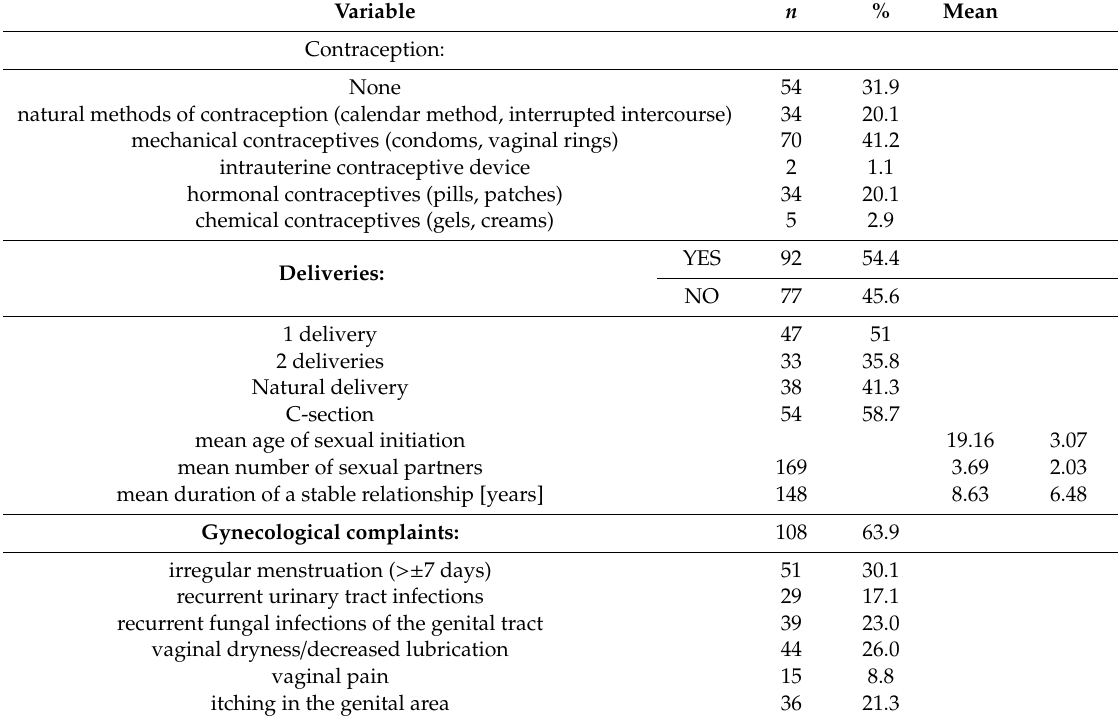
Table 3. Gynecological condition of the studied